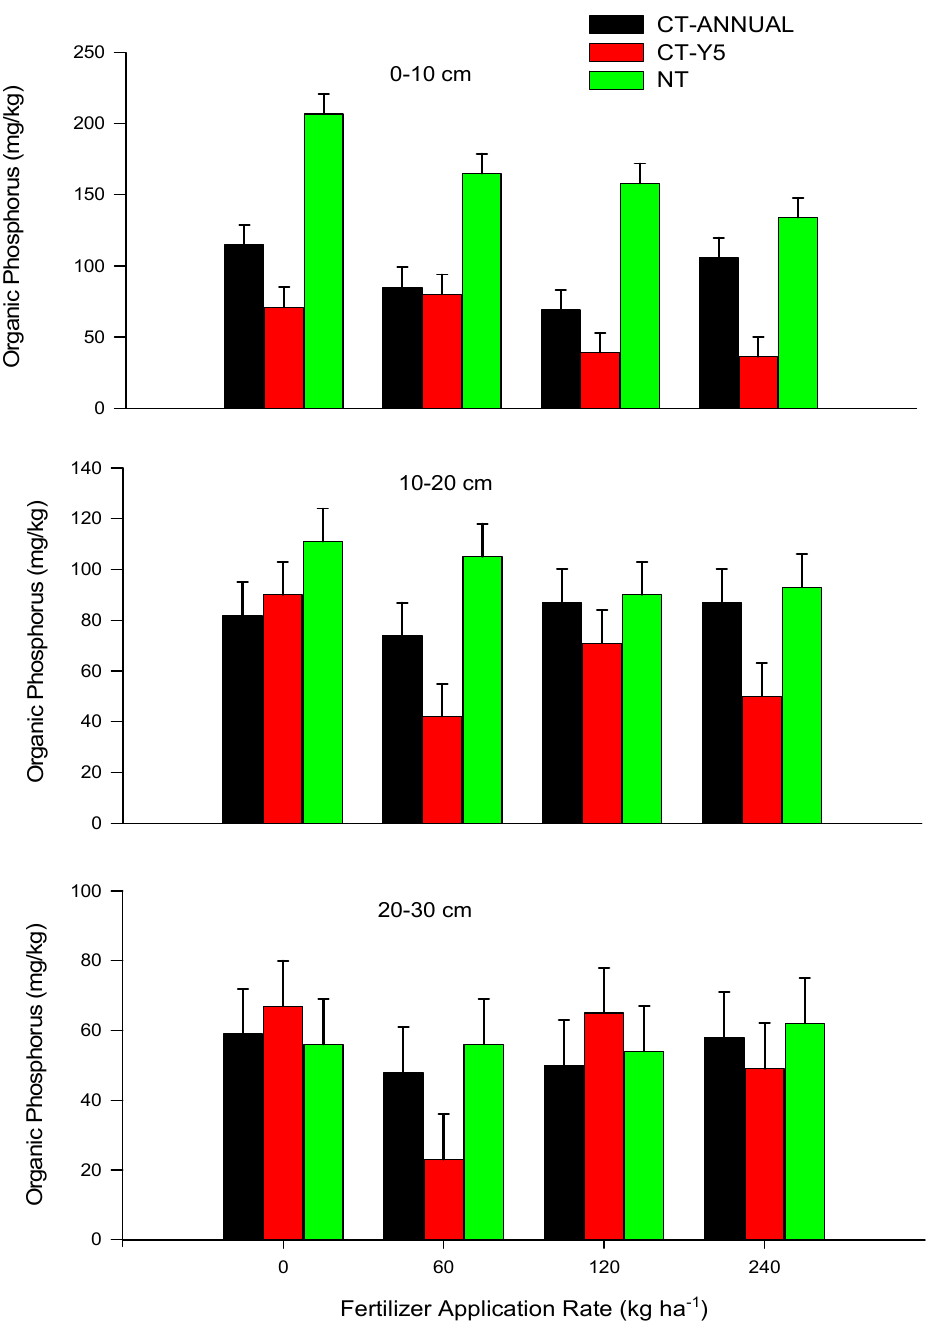
Figure 6. Contents of organic P according to depth under different tillage techniques and urea fertilizer application rates.